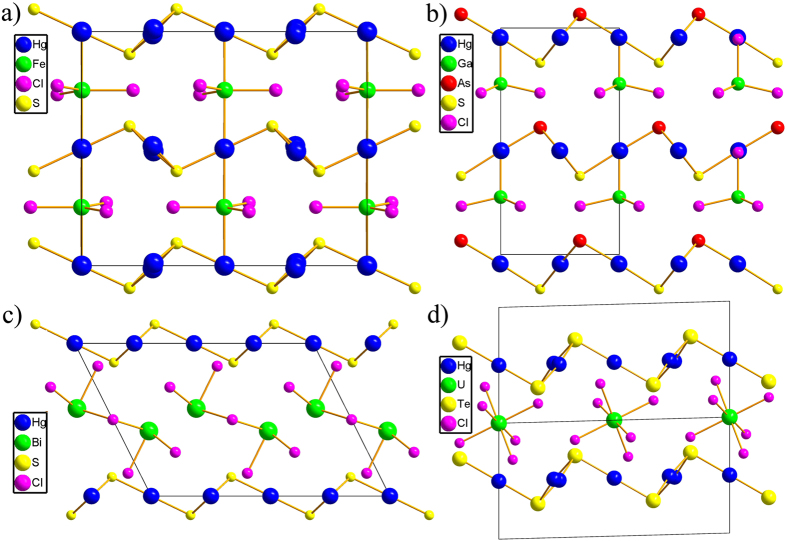
View of different relative locations of neighboring (Hg3Q2)2+ (Q = S, Te, As) layers in (Hg3S2)(FeCl4) (a), (Hg3SAs)(GaCl4) (b), (Hg3Q2)(Bi2Cl8) (c) and (Hg3Te2)(UCl6) (d).